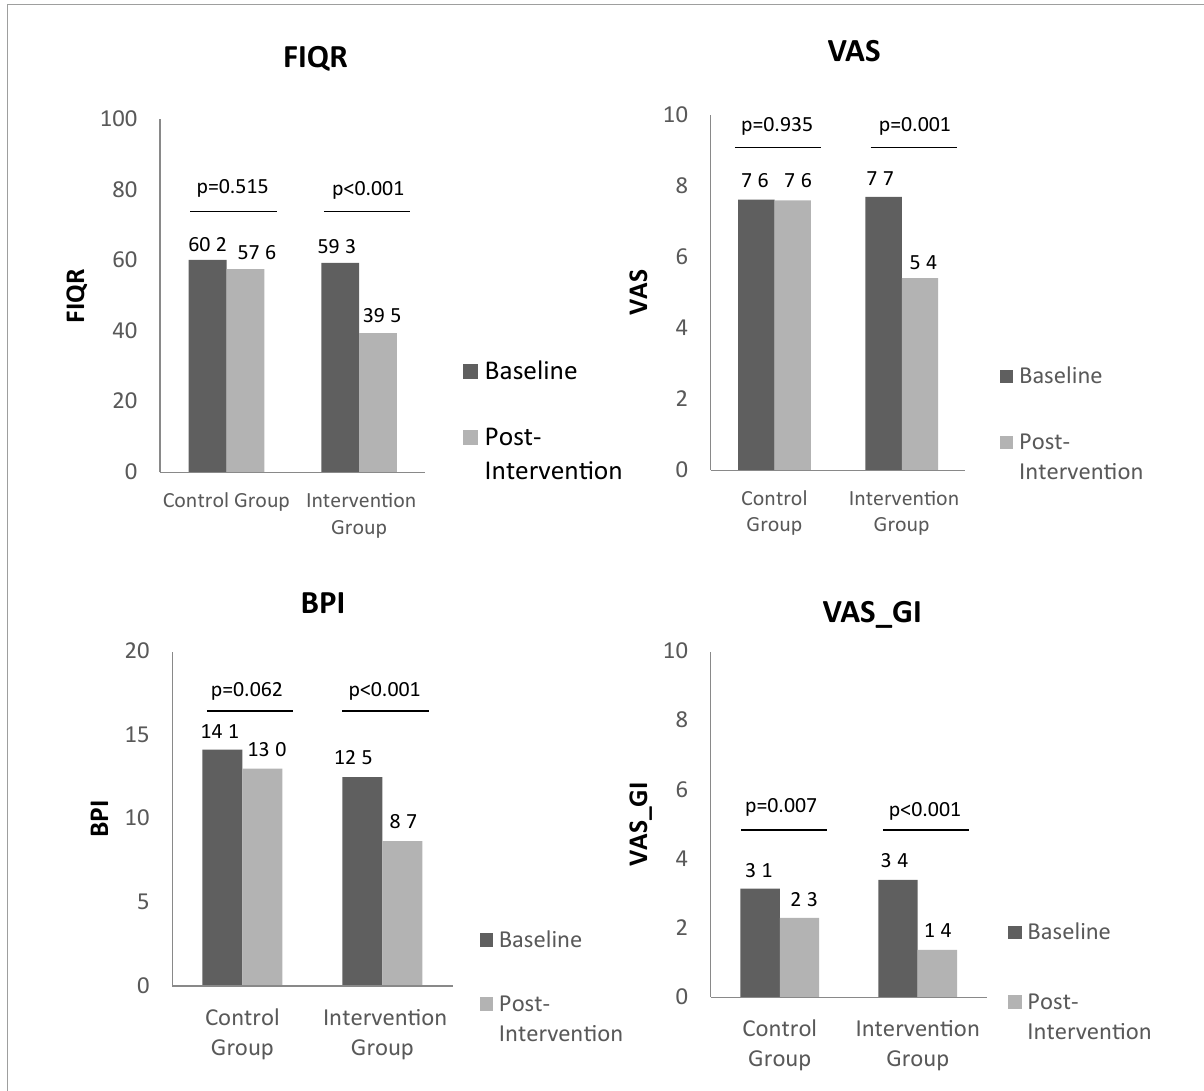
FIGURE1 Between group baseline and post intervention analysis on the impact of fibromyalgia on quality of life, pain, and gastrointestinal symptoms, through FIQR, VAS, BPI, and VAS_GI, respectively. FIQR, Revised Fibromyalgia Impact Questionnaire; VAS, Visual Analogic Scale; BPI, Brief Pain Inventory; VAS GI, Visual Analog Scale from gastrointestinal